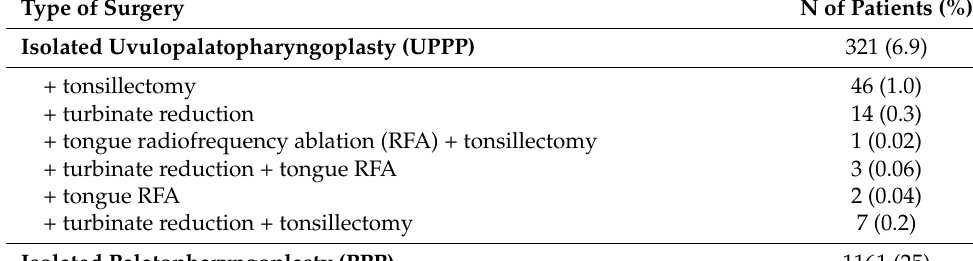
Table 3. (Sub)Types of surgery. Reported as n (%), unless otherwise stated. Type of Surgery N of Patients (%) Isolated Uvulopalatopharyngoplasty